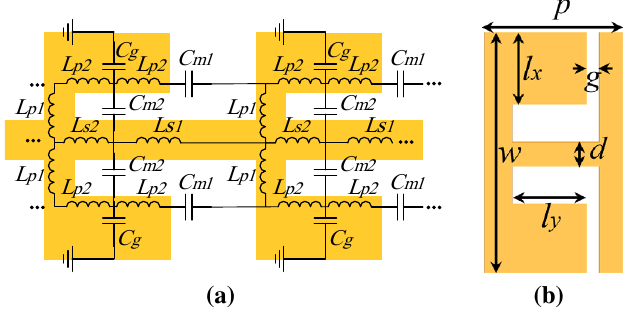
Figure 1. proposed unit cell ( a ) the schematic unit cell and ( b ) equivalent circuit model for two connected